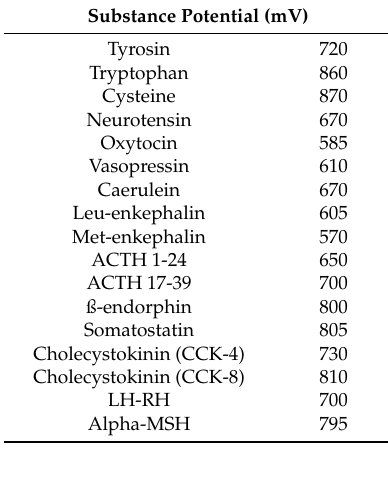
Table 1. In vitro oxidation potential values (mV) of various electro active amino acids and peptides detected with DPV-µCFE in PBS at pH 7.4.